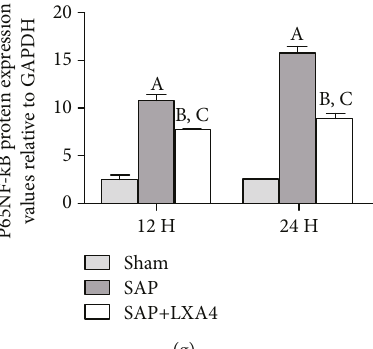
Figure 7: Inhibition of NF- κ B/p65 activation in TNF-R2 (-/-) HPMECs and lung tissue by AT-Lipoxin A4. TNF-R2 (-/-) HPMECs were pretreated with AT-Lipoxin A4 (50 ng/mL) for 1 h and then stimulated with TNF- α (50 ng/mL) for 15min. (a – c) Western blot assay shows expressions of nuclear NF- κ B, cytoplasmic NF- κ B, and total p-NF- κ B in TNF-R2 (-/-) HPMECs. (d, e) Single and merged images show immuno fl uorescence staining of NF- κ B (green) in lung tissue at 12 h or 24h after the procedure. The cell nucleus is stained blue by DAPI. (f, g) Western blot assay shows expressions of total NF- κ B in lung tissue at 12 h or 24 h after the procedure. Beta-actin and Lamin B were used as internal controls, respectively. The data showed representatives of at least three independent experiments. # P < 0 01 compared with the control, ∗∗ P < 0 01 compared with TNF- α in the absence of AT-Lipoxin A4, and ∗ P < 0 05 compared with TNF- α in the absence of AT-Lipoxin A4.